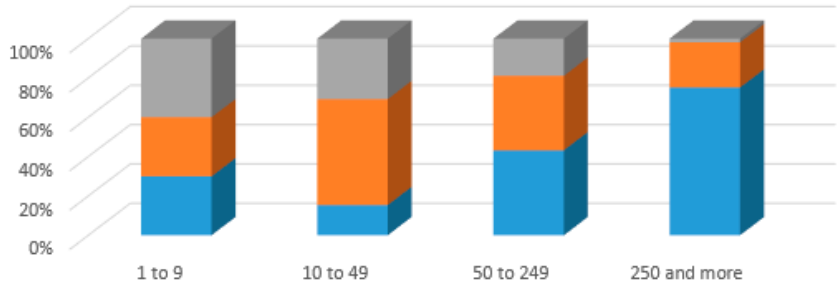
Figure 4. Implementation of Industry 4.0 depending on the size of the company.